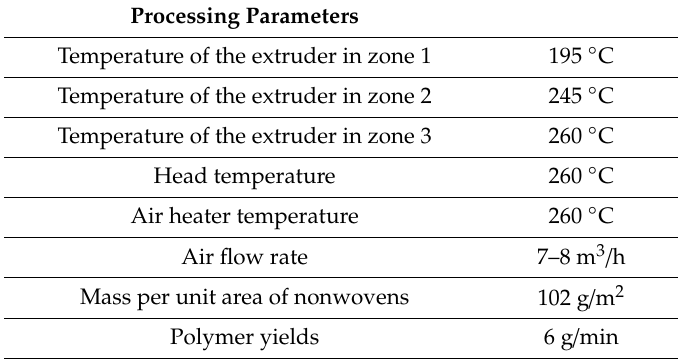
Table 2. Technique processing parameters applied for preparation of Poly(lactic acid) nonwoven.